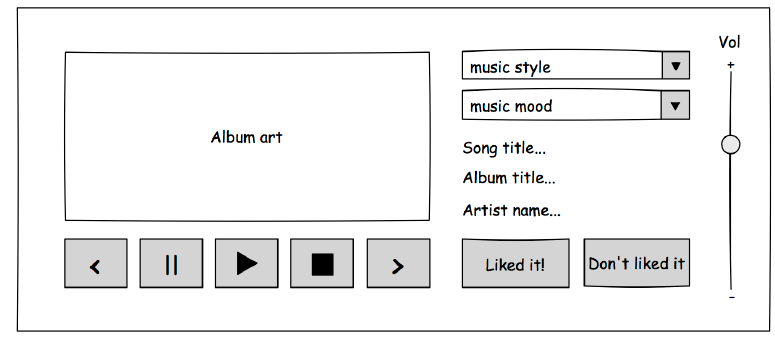
Figure 5. Sketched UI of the Environmental Music Player using WIMP user interfaces. Algorithm 1. Reduced XML code describing the Abstract UI model for the EMP. ...